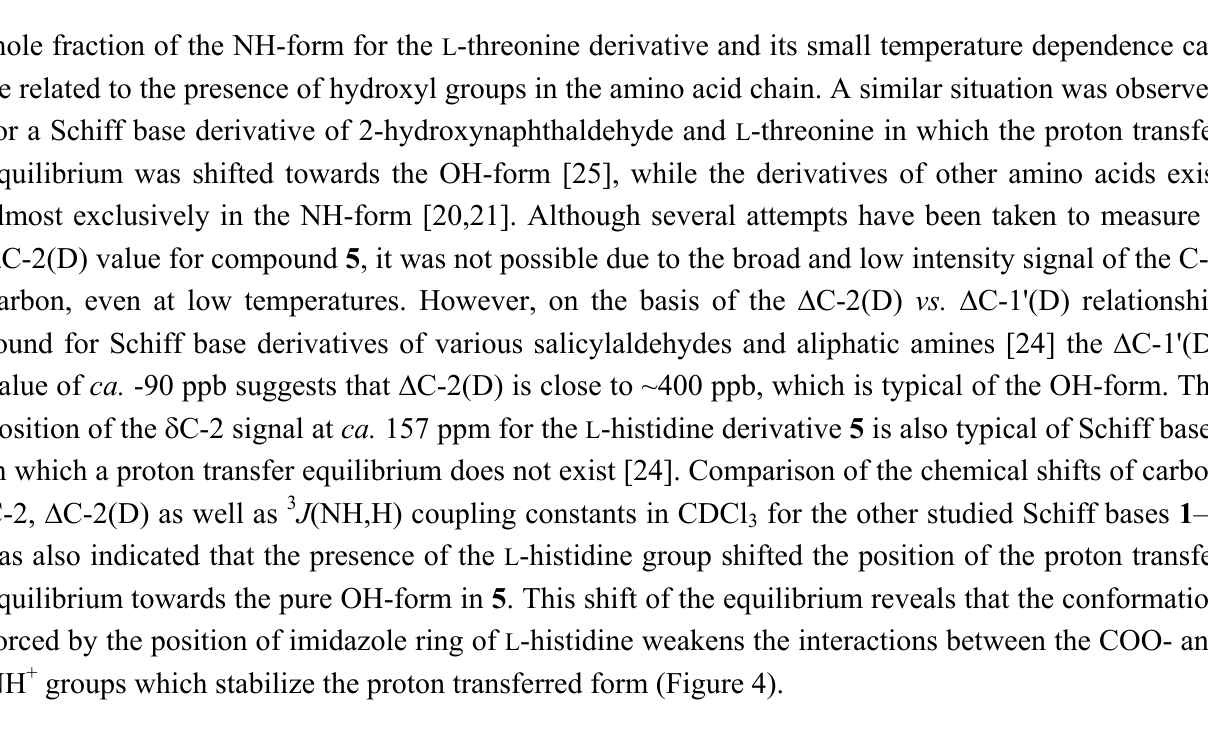
Figure 4. Influence of the imidazole ring on the conformation of 5